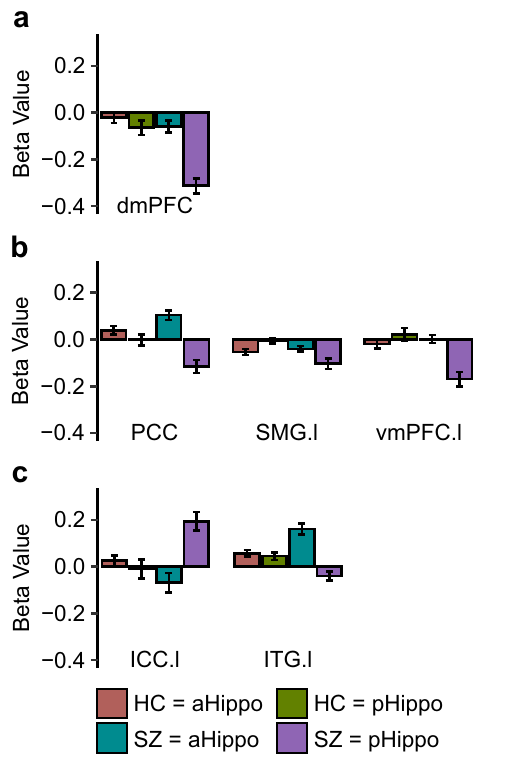
Fig. 2 Beta coef fi cients of signi fi cant diagnosis by seeds connectivity results. a Results from the interaction diagnosis-by- seeds of the left hemisphere in the encoding condition. Hippocampus-dmPFC connectivity (beta values from left to right: − 0.02, − 0.07, − 0.06, − 0.31); b Results from the interaction diagnosis-by-seeds of the left hemisphere in the retrieval condition, hippocampus-PCC connectivity (beta values: 0.04, − 0.002, 0.10, − 0.12), hippocampus-SMG connectivity (beta values: − 0.05, − 0.005, − 0.04, − 0.10), Hippocampus-vmPFC connectivity (beta values: − 0.02, 0.02, 0.002, − 0.17); c Results from the interaction diagnosis- by-seeds of the right hemisphere in the retrieval condition. Hippocampus-ICC connectivity (beta values: 0.03, − 0.01, − 0.07, 0.19), hippocampus-ITG connectivity (beta values: 0.06, 0.04, 0.16, − 0.04). HC healthy controls, SZ schizophrenia patients, aHippo anterior hippocampus, pHippo posterior hippocampus, vmPFC ventromedial prefrontal cortex, ICC intracalcarine cortex, dmPFC dorsomedial prefrontal cortex, PCC posterior cingulate cortex, SMG supramarginal gyrus, ITG inferior temporal gyrus, l left, r right. Error bars represent the standard error of the mean (s.e.m.).